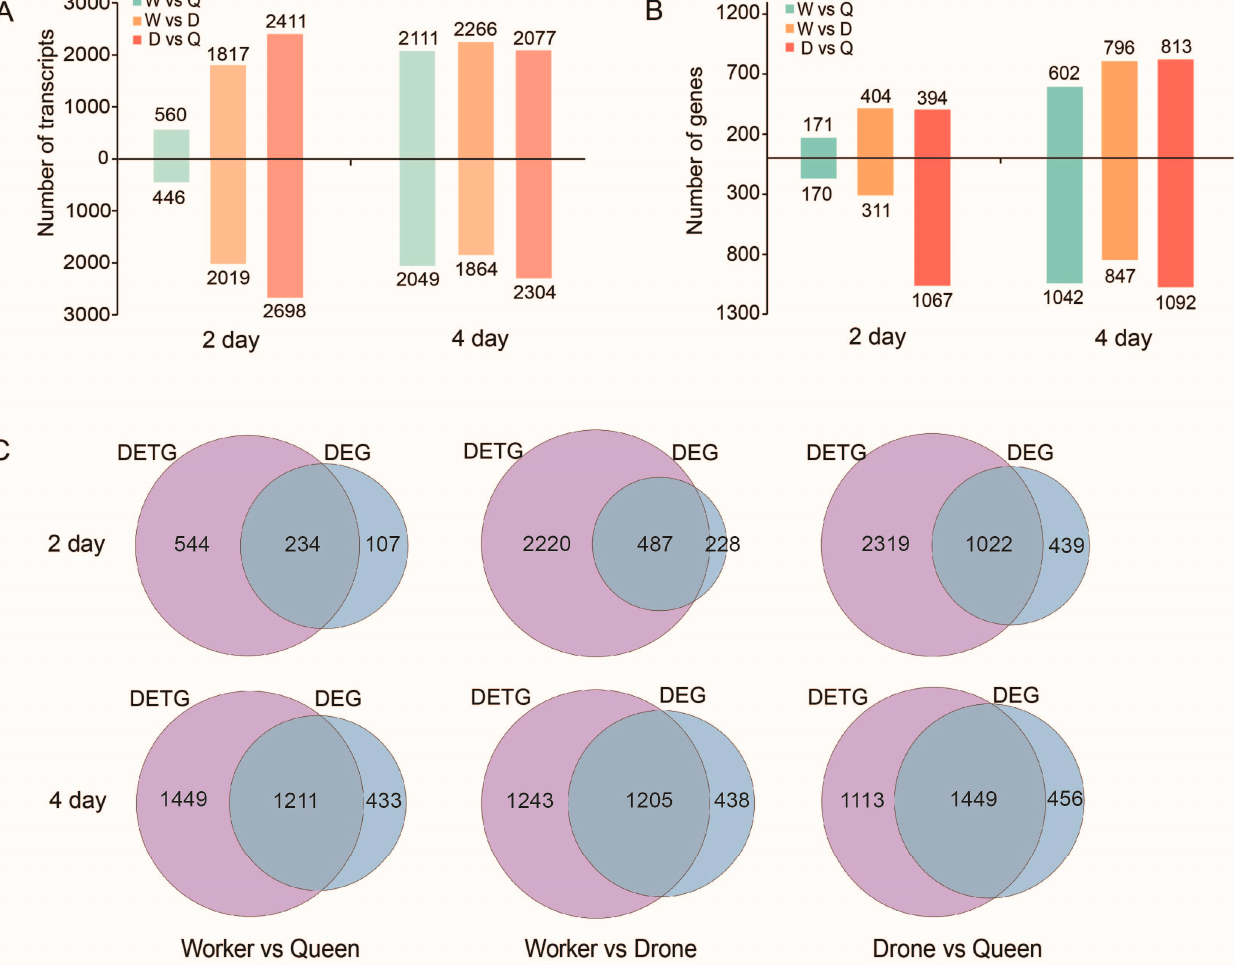
Figure 7. The DETs and DEGs between castes at larvae stage. The DETs ( A ) and DEGs ( B ) among queen, worker and drone at 2-day and 4-day larvae stages. ( C ) The overlapped genes between DETGs and DEGs.